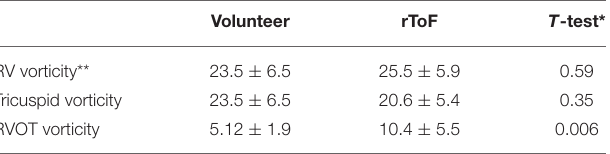
TABLE 2 | Vorticity in the volunteer and study